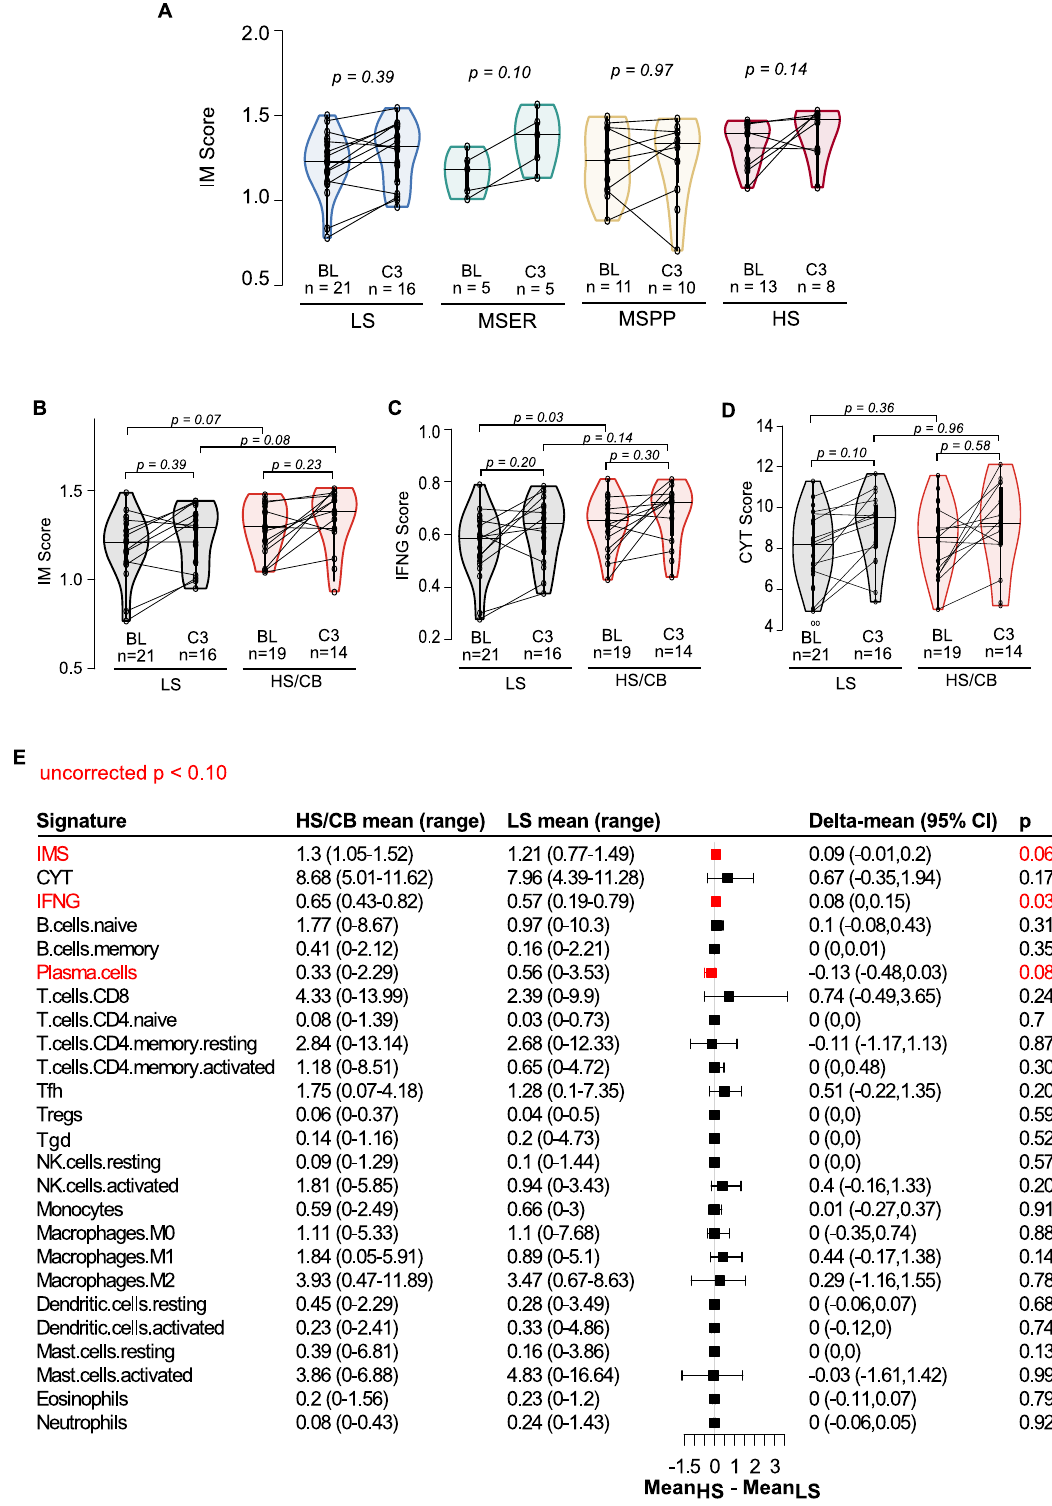
The signatures of immunological activity varied by cancer types and their distributions were largely overlapping (Supple- mentary Fig. 7A). Signi fi cant correlation was observed between all three signatures, with the strongest concordance between IM and IFNG scores (Spearman correlation = 0.92, p < 0.01) (Supple- mentary Fig. 7C). When comparing signatures across sensitivity strata (Fig. 3A and Supplementary Fig. 7B), we observed the